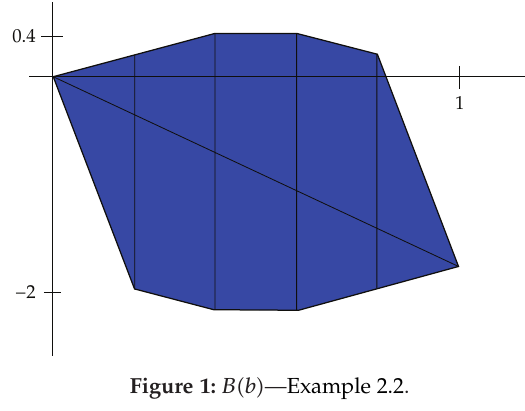
Figure 1: B (cid:2) b (cid:3) —Example